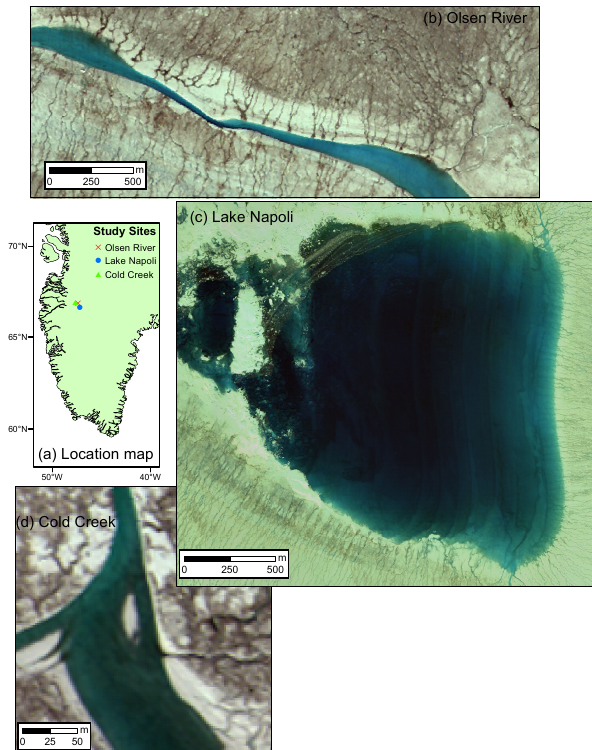
Fig. 1. Map (a) indicating the location of study area in southwest- ern Greenland. WorldView2 images of three primary field sites: (b) Olsen River, (c) Lake Napoli, and (d) Cold Creek. See Table 1 for more information on each site.